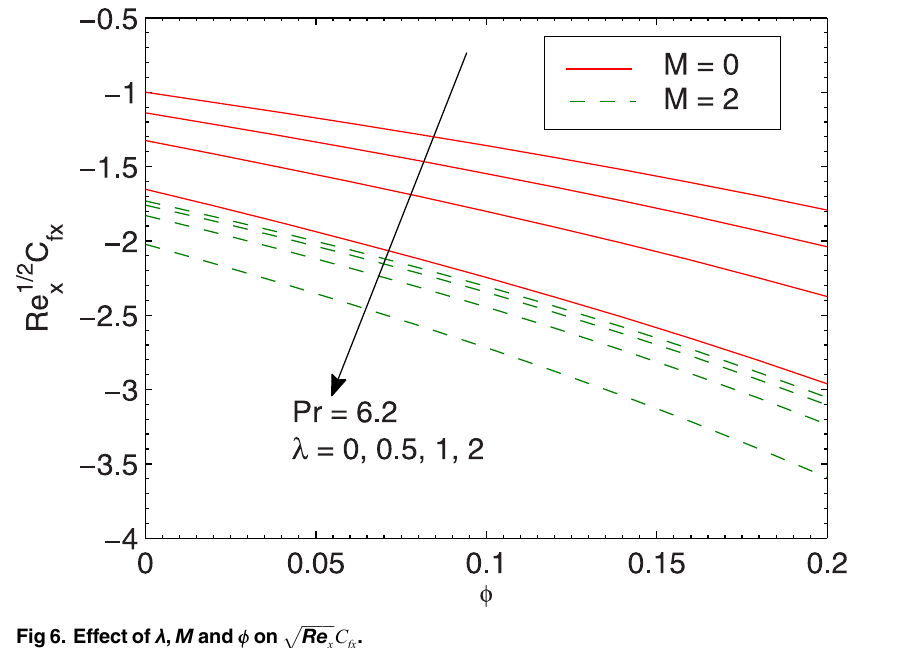
Fig 6. Effect of λ , M and ϕ on